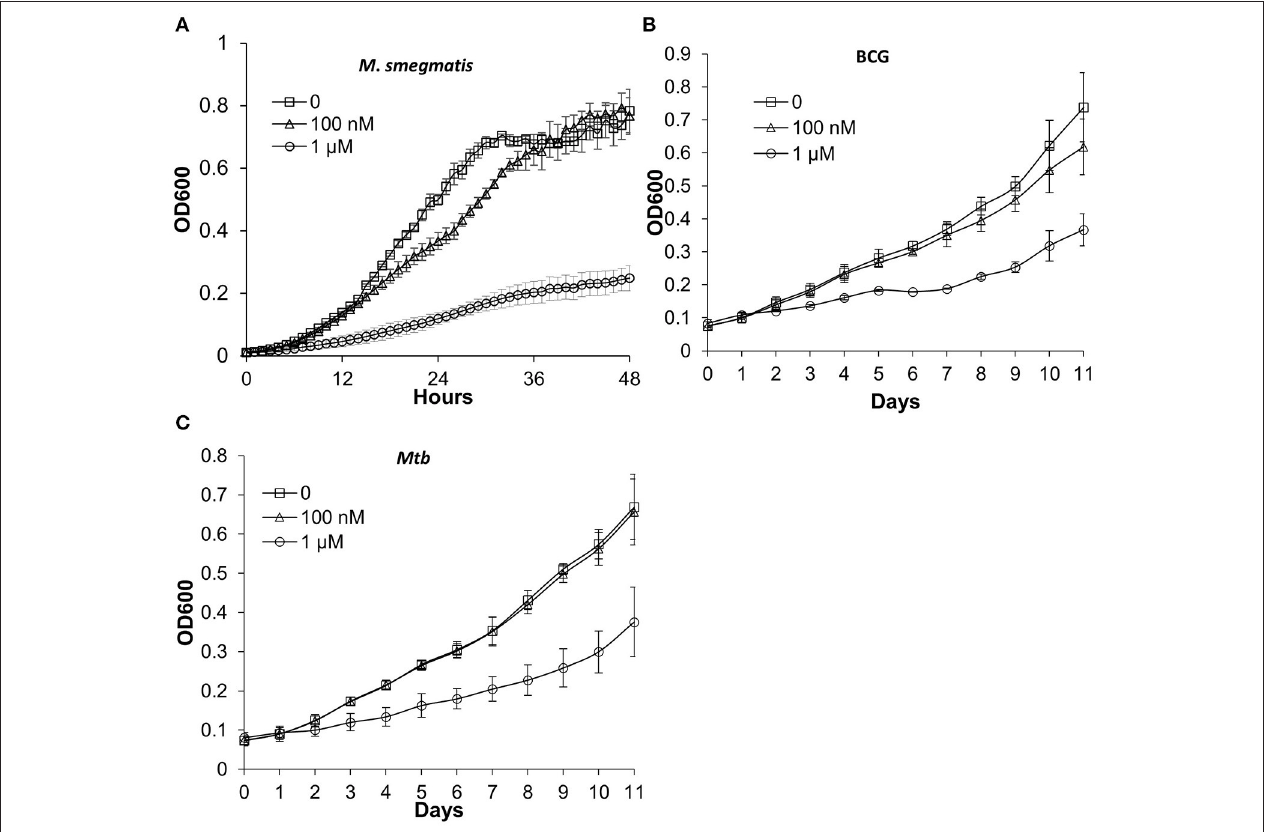
FIGURE 3 | Mycobacterial growth curves in the presence or absence of DLF-1. (A–C) represent the growth curve of each mycobacterium in media containing 0, 100 nM, 1 µ M of DLF-1, respectively. (A) Mycobacterium smegmatis ; (B) Mycobacterium bovis BCG; (C) Mycobacterium tuberculosis CDC1551. Error bars represent standard errors of means calculated based on results from three independent